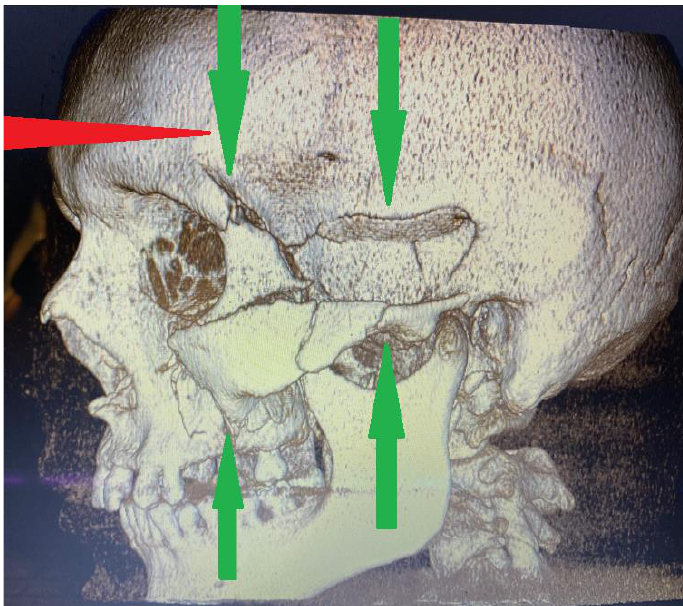
Figure 5. Three-dimensional reconstruction of the fractured area. The red arrow marks the entirely preserved frontal area. The major impact force was focused on the left orbit, zygomatic, and temporal bone areas. Green arrows indicate the fracture lines at the zygomatico-temporal suture, zygomatic bone, prominence with arch, anterior part of the maxillary sinus wall, lateral wall of the left eye socket, inferior border of the left orbit, and the temporal bone. No zygomatic bone-coronoid process of the mandible conflict was present.